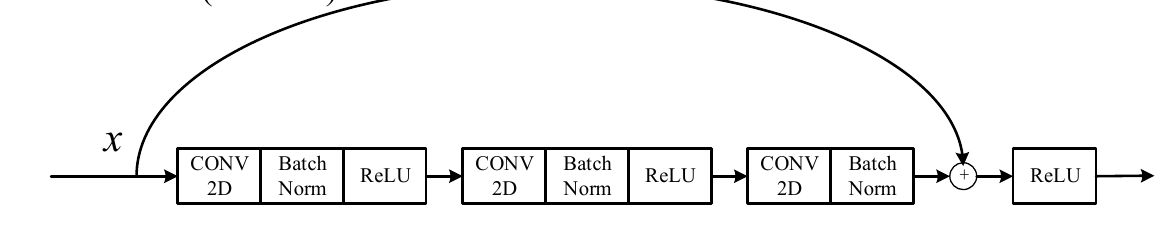
Figure 10. ID BLOCK structure.